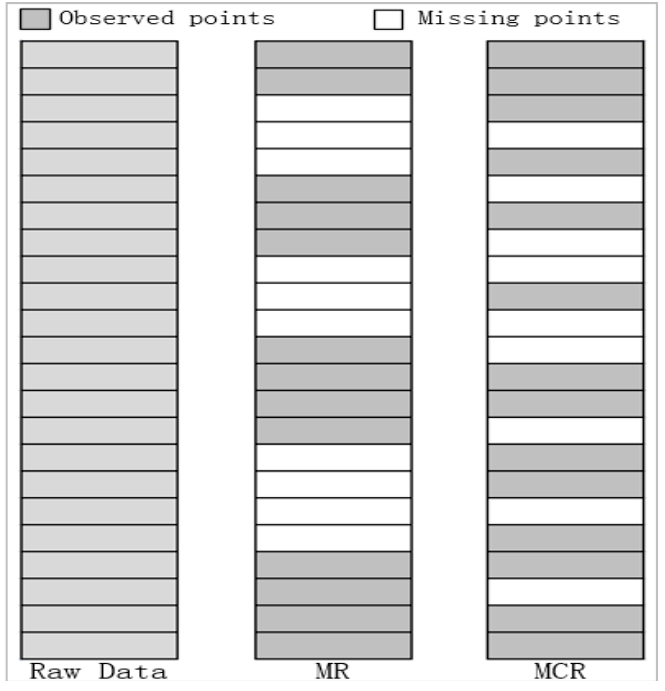
Figure 3. The schematic diagram of the MR and MCR.